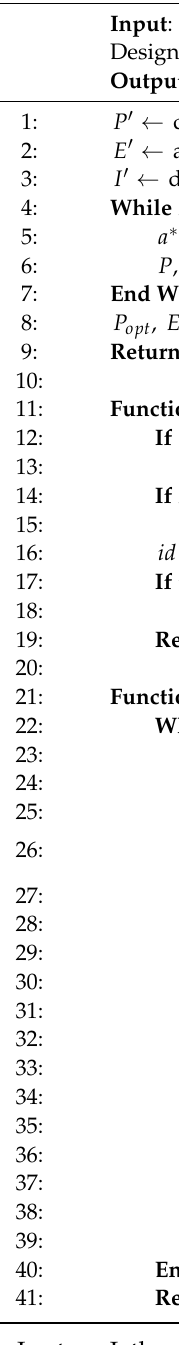
Algorithm 2 AlphaTruss Stage